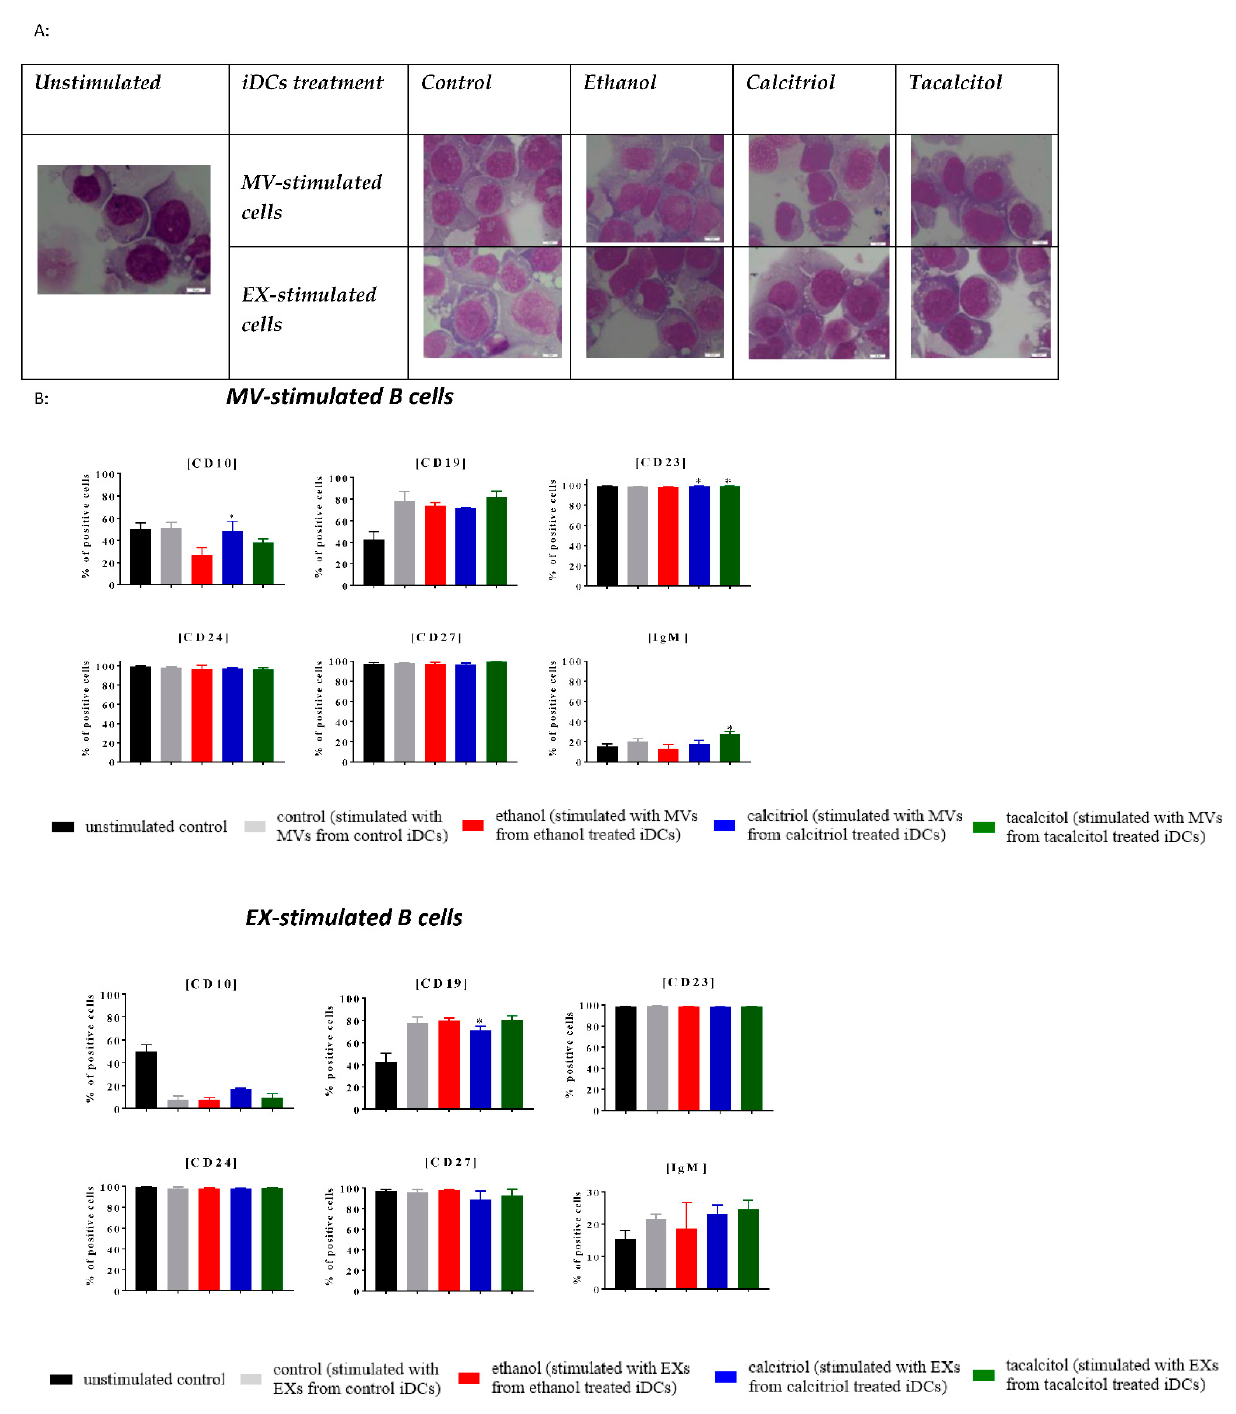
Figure 9. The indirect effects of calcitriol and tacalcitol on LCL cell line after 24 h of stimulation with EVs derived from iDCs: ( A ) morphology of EV-stimulated LCL cell line; scale bar 10 μ m. Each staining was independently performed twice; ( B ) distribution of differentiation markers by flow cytometry analysis. Mean values and standard deviation are presented. Statistical analysis: Sidak’s multiple comparison tests in comparison with ethanol were performed; significant differences as compared with ethanol (* p < 0.005). Each experiment was performed at least 3 times .